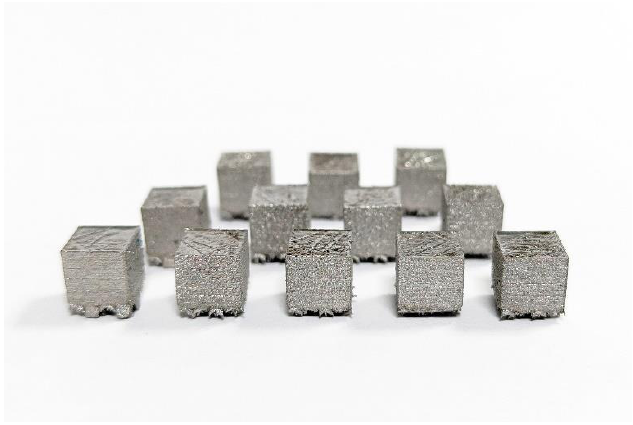
Figure 2. Cubic samples synthesized by LPBF after removing from substrate.